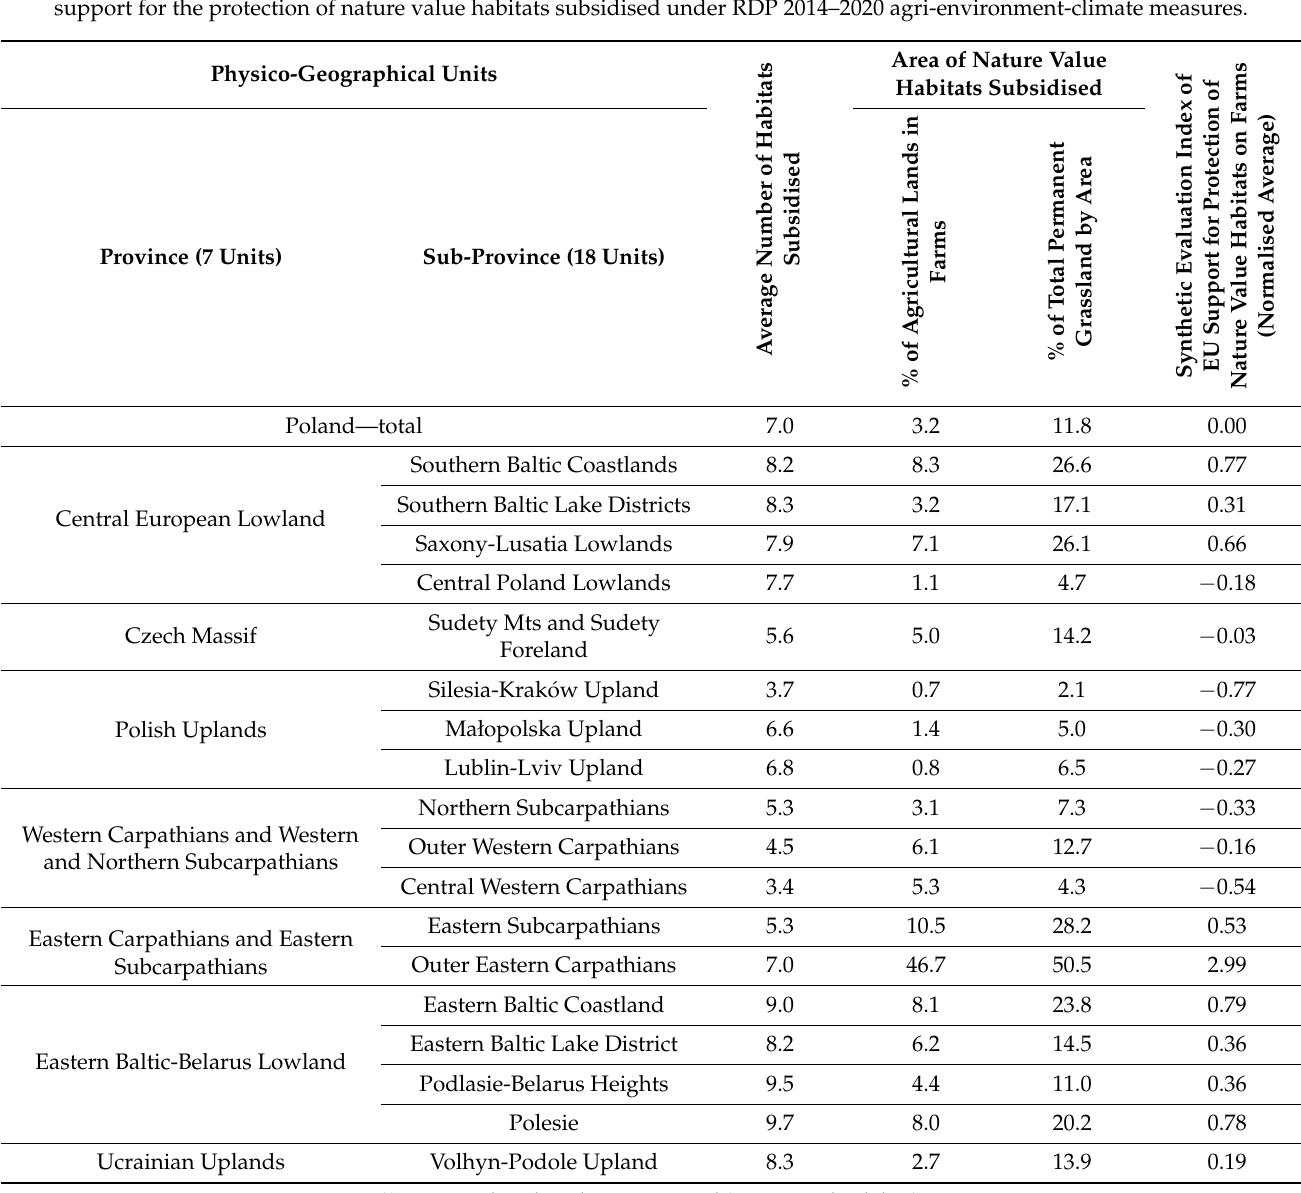
Table 3. Units of the physical and geographic division of Poland—selected evaluation criteria and synthetic evaluation of support for the protection of nature value habitats subsidised under RDP 2014–2020 agri-environment-climate